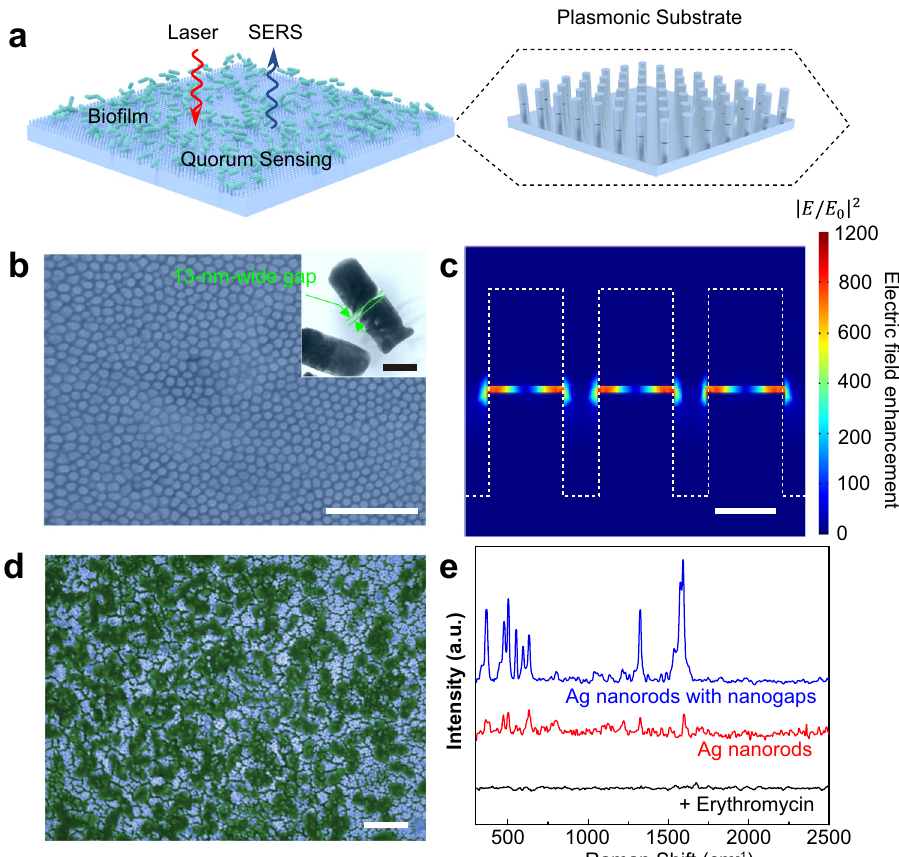
Fig. 4 Detection of quorum sensing in P. aeruginosa bio fi lms using the fabricated plasmonic nanostructure substrate. a Schematic illustration of detection of quorum sensing regulated metabolites in bio fi lms by using surface-enhanced Raman spectroscopy. b SEM image of the Ag nanorod array with built-in nanogaps. Inset: TEM image showing a built-in 13-nm-wide gap in the middle of an individual nanorod. c Calculated electric fi eld intensity in the nanorod array. Color scale shows the calculated electric fi end enhancement factor. d Pseudocolour SEM image of the P. aeruginosa bio fi lm grown on the plasmonic substrate. e Raman spectra of the bio fi lm grown on the gapped Ag nanorod substrate (blue line), Ag nanorod substrate (red line), and the gaped Ag nanorod substrate with 100 μ g ml − 1 erythromycin (black line). Scale bars, 2 μ m ( b , d ) and 100 nm ( c , inset of b